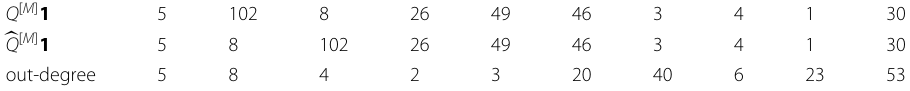
Table 4 Real: Top 10 ranked nodes: exact, approximate and with aggregate out-degree Q [ M ] 1